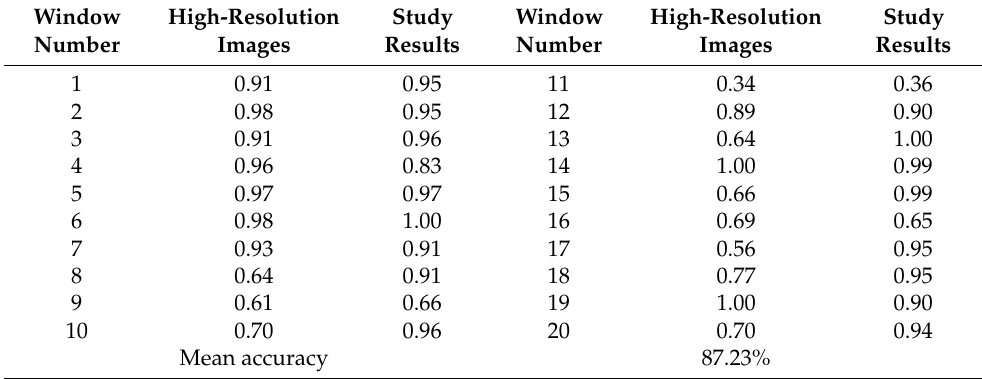
Figure A3. Comparison of NPP obtained from the CASA model and MODIS products in 2018. Table A4. Verification results of FVC in 2000.